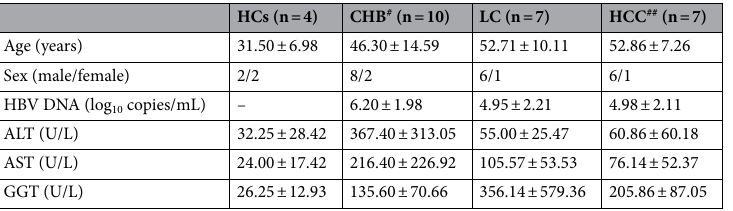
Table 2. Clinical characteristic of the subjects. Data are expressed as the means ± standard deviation or n. ALT Alanine aminotransferase, AST Aspartate aminotransferase, CHB Chronic hepatitis B, HCs Healthy controls, HCC Hepatocellular carcinoma, LC Liver cirrhosis, GGT Gamma glutamyl transferase. # Treatment-naïve active CHB patients. ## Newly diagnosed cases of HCC without any